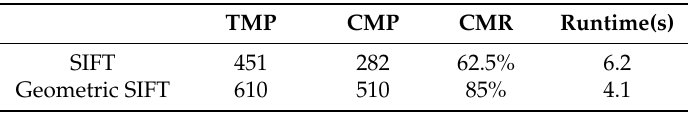
Figure 8. Performance of the proposed geometric SIFT. ( a ) Matching result by SIFT; ( b ) Matching result by proposed geometric SIFT. Table 1. Test the performance of geometric SIFT.